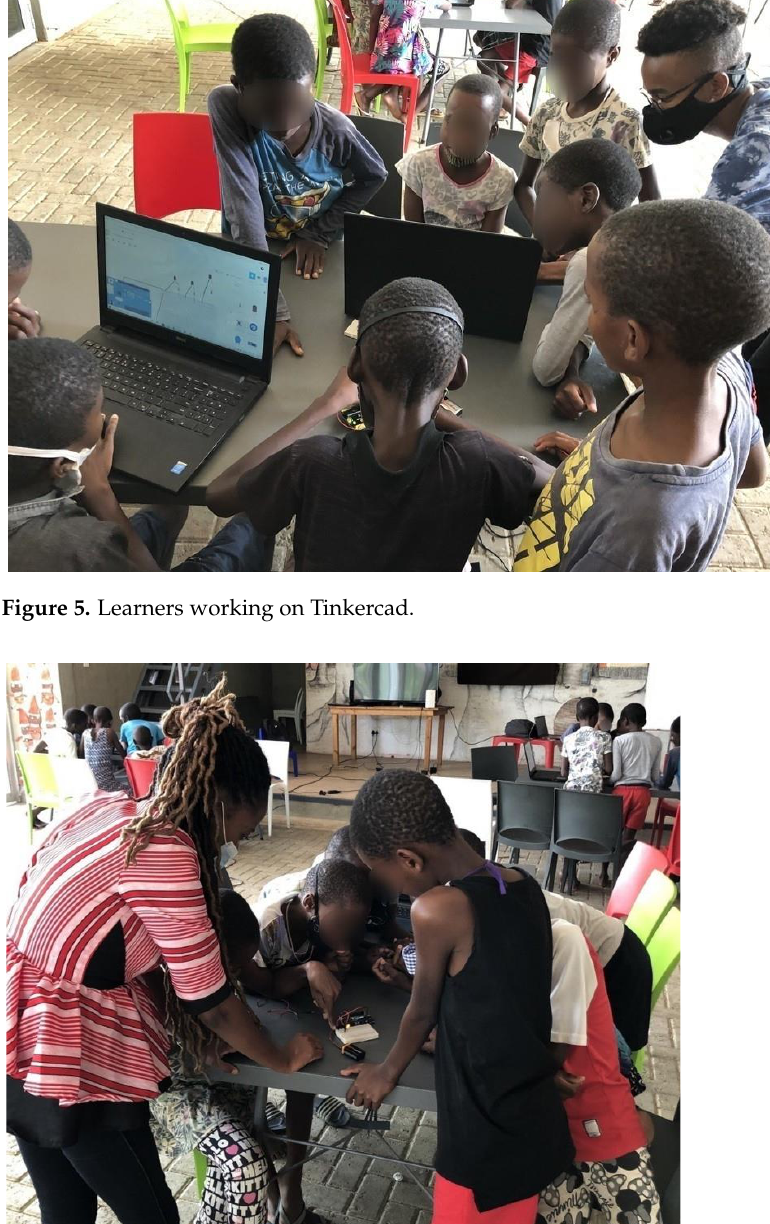
Figure 7. Task 2: LED lights